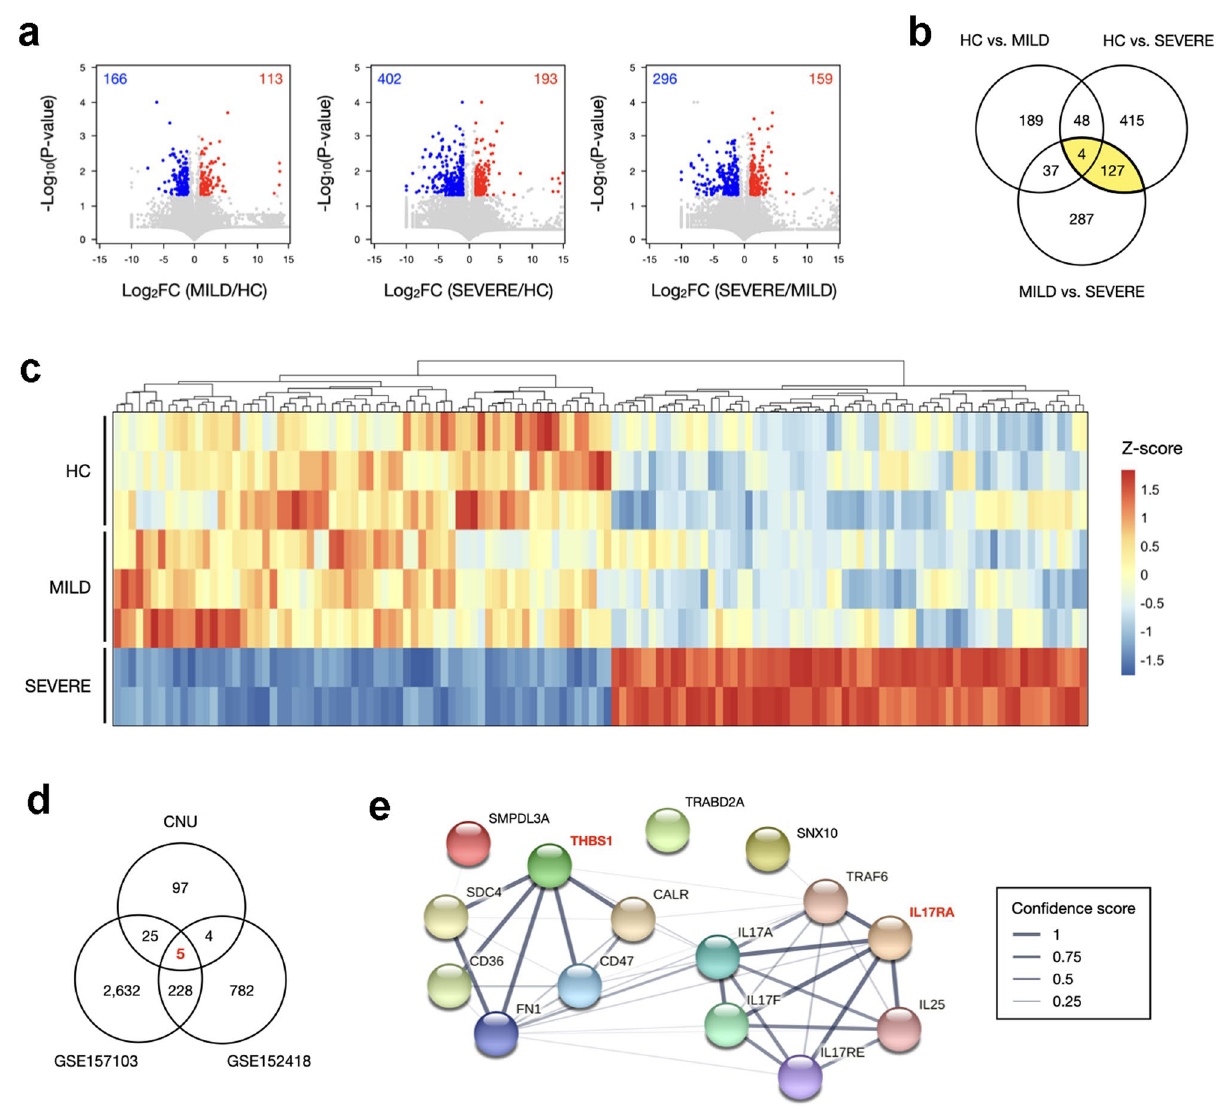
Figure 1. RNA-seq based transcriptome profiling of PBMCs from COVID-19 patients and healthy controls. ( a ) Volcano plots representing differentially expressed genes (DEGs) with the log2-fold change plotted against the negative log10 p-value for the three groups. Red and blue dots indicate significantly upregulated and downregulated genes, respectively. ( b ) Venn diagram showing the overlap of DEGs among each comparison. ( c ) A heatmap shows commonly identified 131 DEGs of HC versus SEVERE and MILD versus SEVERE. Expression levels are normalized to Z-score and cluster by Euclidean distance matrix. ( d ) Venn diagram showing the overlap of genes among each comparison of two publicly downloaded datasets and our own RNA-seq data. ( e ) Protein network analysis using the STRING In the severe COVID‑19 patients, IL17RA was mainly expressed in monocytes and neutro‑ phils, whereas THBS1 was highly expressed in platelets. To investigate which immune-related cell types are responsive to IL17RA and THBS1 , we used the GSE174072 cohort 34 scRNA-Seq data consisting of over 175,000 single transcriptomes from 33 COVID-19 patients and 8 healthy controls with WHO COVID-19 severity scores. Given preprocessed scRNA-Seq data, we visualized them in two dimensions using the uniform manifold approximation and projection (UMAP) method and obtained the same plot as the original study (Sup- plementary Fig. 3). In the 14 distinct cell type clusters by UMAP plotting, IL17RA expression was most abun- dantly observed in ‘ CD14 -positive monocyte’ and ‘neutrophil’ cell types. On the other hand, THBS1 expression showed distinctly different patterns, which was just a weak expression in ‘ CD14 -positive monocytes’ and no evident expression in ‘neutrophil’ cell types, but mainly observed in ‘platelets’ (Fig. 2a). We next questioned whether these gene expression patterns are predictive of COVID-19 severity scores. In general, the expression levels of IL17RA gene had significantly positive correlations with COVID-19 severity scores in CD14 - positive monocytes ( ρ = 0.474 and P = 0.0017) and neutrophils ( ρ = 0.488 and P = 0.0016) (Fig. 2b, left panels). Notably,